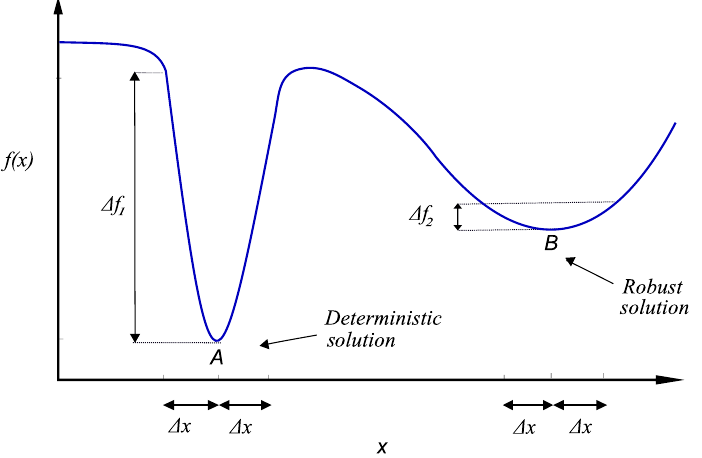
Figure 1. Illustration of global versus robust